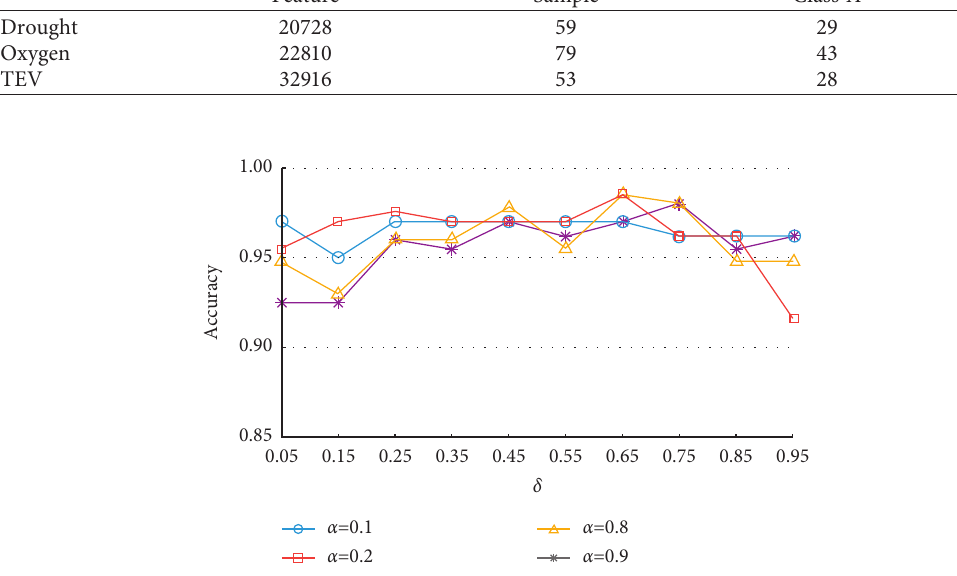
Figure 4: Average accuracies of ECHDNRS on Arabidopsis -Drought